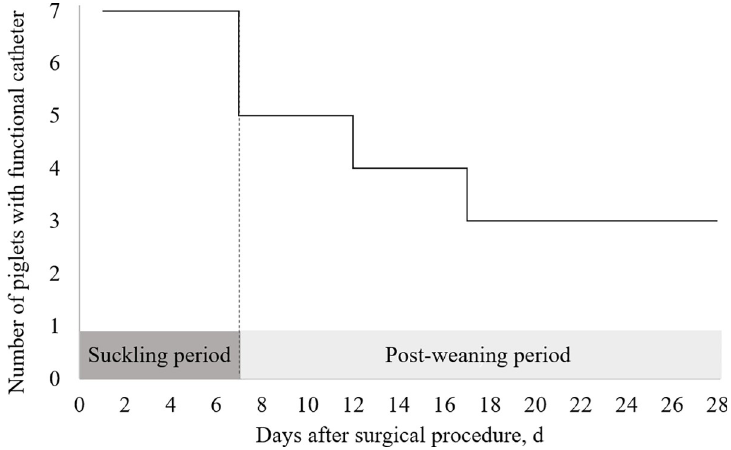
Fig 4. Preservation of catheter function in catheterized piglets ( n = 7) during the suckling and the post-weaning